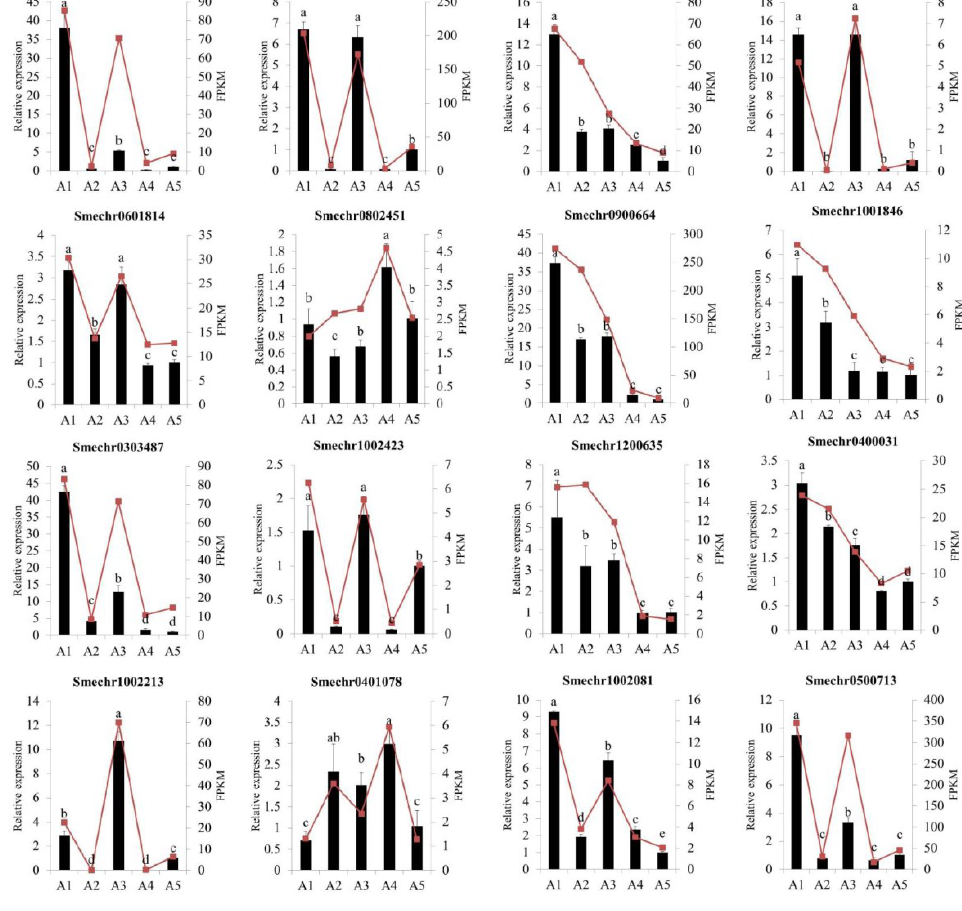
Figure 10. Quantitative real-time PCR analysis of the sixteen DEGs among the five eggplant cultivars. The different letters on top of each bar indicate significant differences among the five eggplant varieties at p < 0.05.